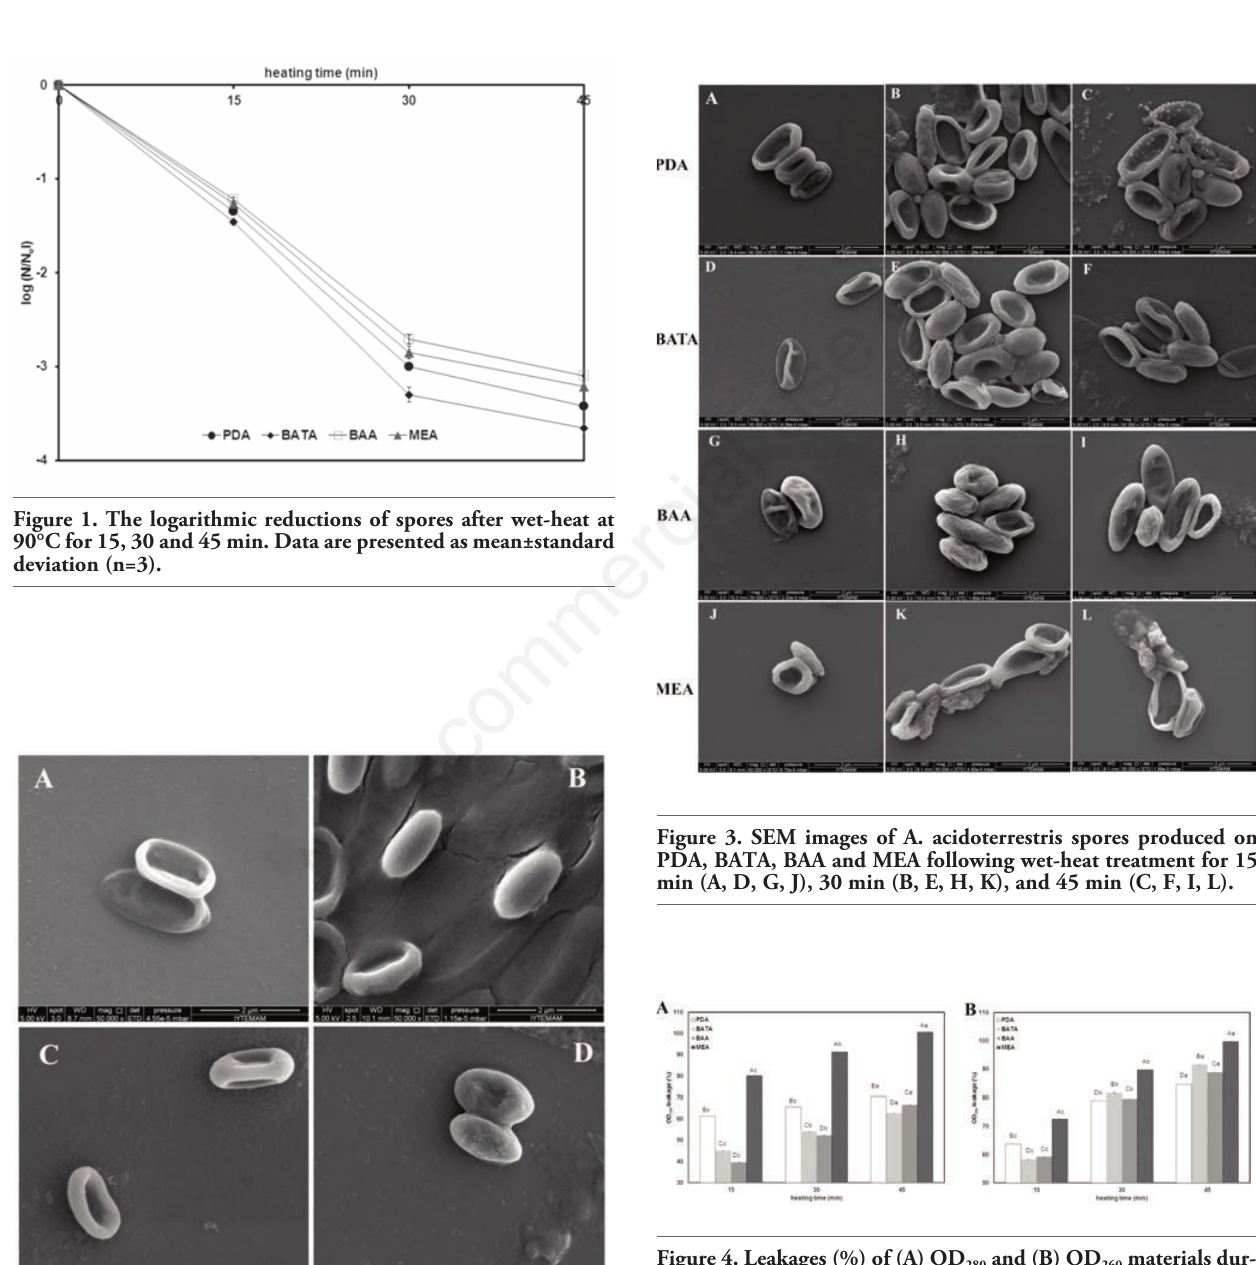
Figure 4. Leakages (%) of (A) OD and (B) OD materials dur- 280 260 ing wet-heat at 90°C for 15, 30 and 45 min. Data are presented as mean±standard deviation (n=3). Within the same sampling time, values with different capital letters are significantly different (P<0.05). Within the same spore suspension, values with different lower case are significantly different over time